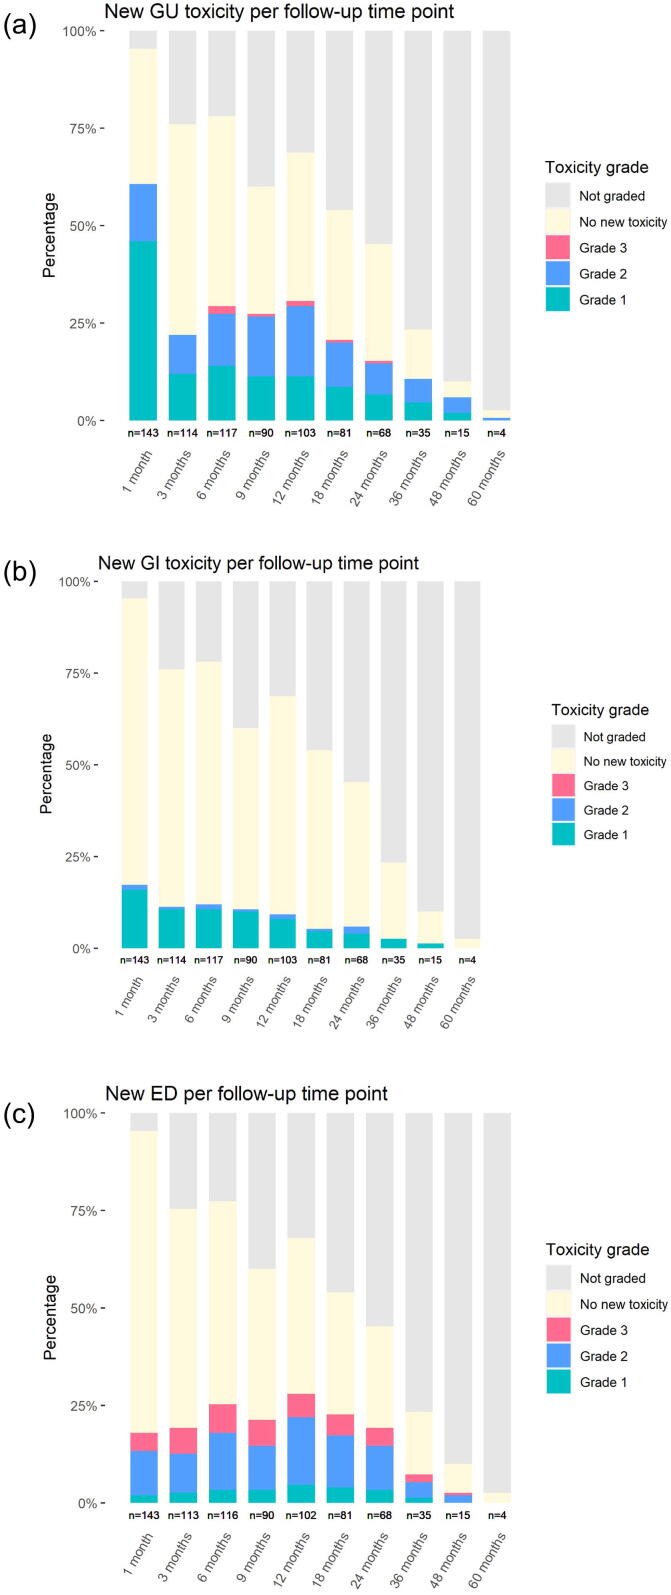
a–c: Stacked barplots displaying number of patients with new-onset toxicity after ultrafocal salvage HDR-BT. At each follow-up time point, toxicity scores were compared with baseline. Any score above baseline was considered new-onset toxicity.